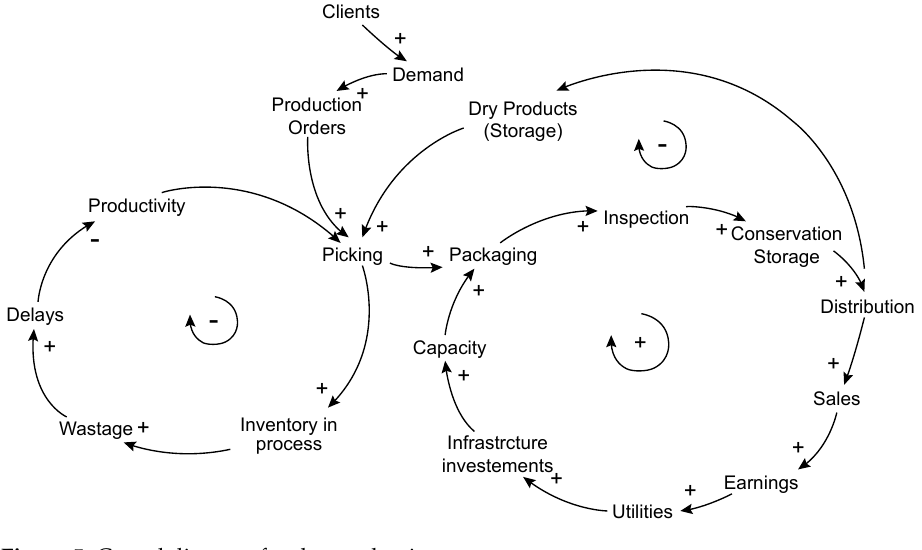
Figure 6. Forrester diagram of the packaging process. The packaging process is activated by a production order subjected to the demand ordered by the final consumer. This production order indicates the necessary kilograms of the set of products for each package. When the order is launched, picking is performed where only the products required are taken to subsequently carry out the demand. All merchandise goes through the packaging area with a unit in kilograms to convert them to products between those that each product weighs according to their characteristics. After that, the packages go through an inspection, and, finally, to the conservation area to be distributed on time and form. It is important to highlight that any type of package conveys the same process. Package 1 is formed by noodles (400 g), spaghetti (400 g), elbow macaroni (400 g), rice (500 g), beans (1 kg), and canned tuna fish (280 g). Package 2 contains whole milk (2.1 L), fruit ring multigrain cereal (200 g), wheat cereal (150 g), and frosted corn flake cereal (200 g). Package 3 contains noodles (400 g), spaghetti (400 g), elbow macaroni (400 g), rice (500 g), beans (1 kg), canned tuna fish (280 g), coffee (50 g), and cooking oil (0.475 L). Lastly, Package 4 needs noodles (400 g), spaghetti (400 g), elbow macaroni (400 g), rice (1